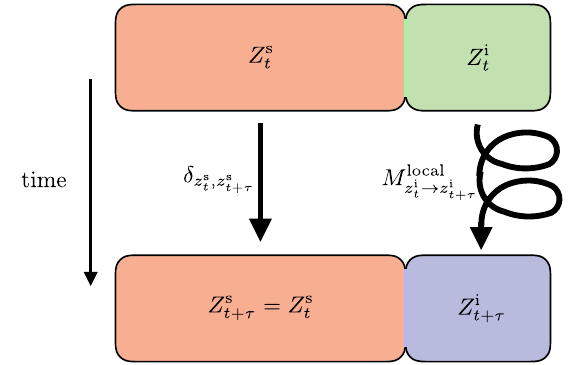
FIG. 1. Local computations operate on only an interacting subset Z int of the entire information reservoir Z ¼ Z int ⊗ Z stat described by random variable Z ¼ Z i ⊗ Z s . The Markov channel that describes the global dynamic is the product of a local operation with the identity operation: M global δ M local , such that the stationary noninteracting portion Z s z s t ;z s t þ τ z i t → z i t þ τ of the information reservoir remains invariant, but the interacting portion Z i